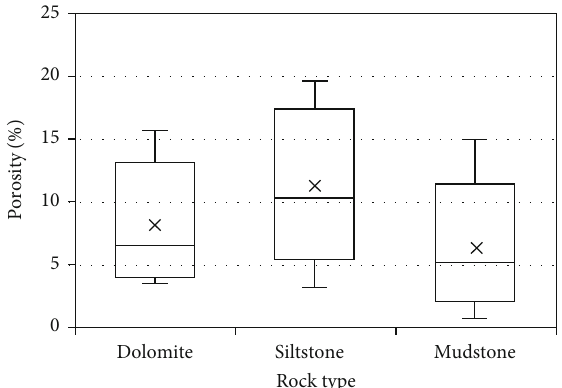
Figure 15: Box diagram of porosity distribution of samples from Lucaogou formation.